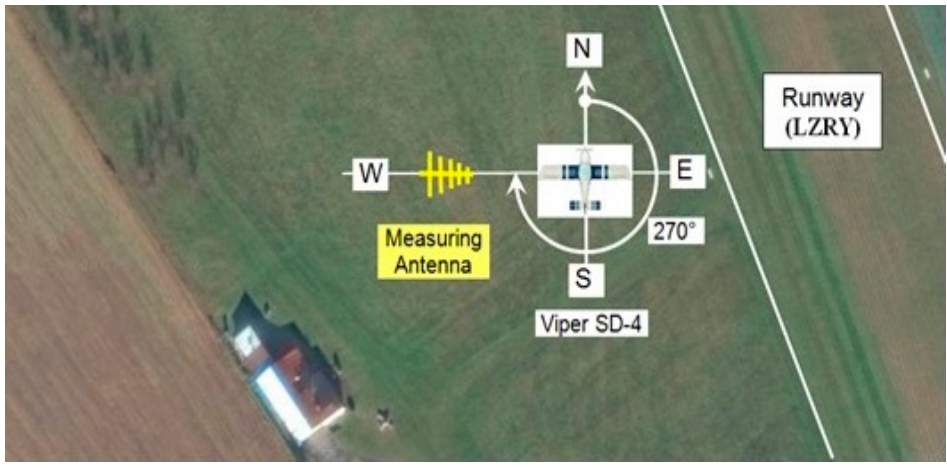
Figure 3. Orientation of the measuring workplace at Raž ň any